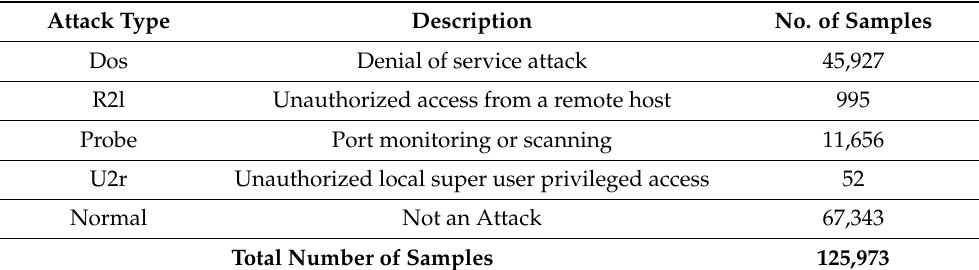
Table 1. Dataset